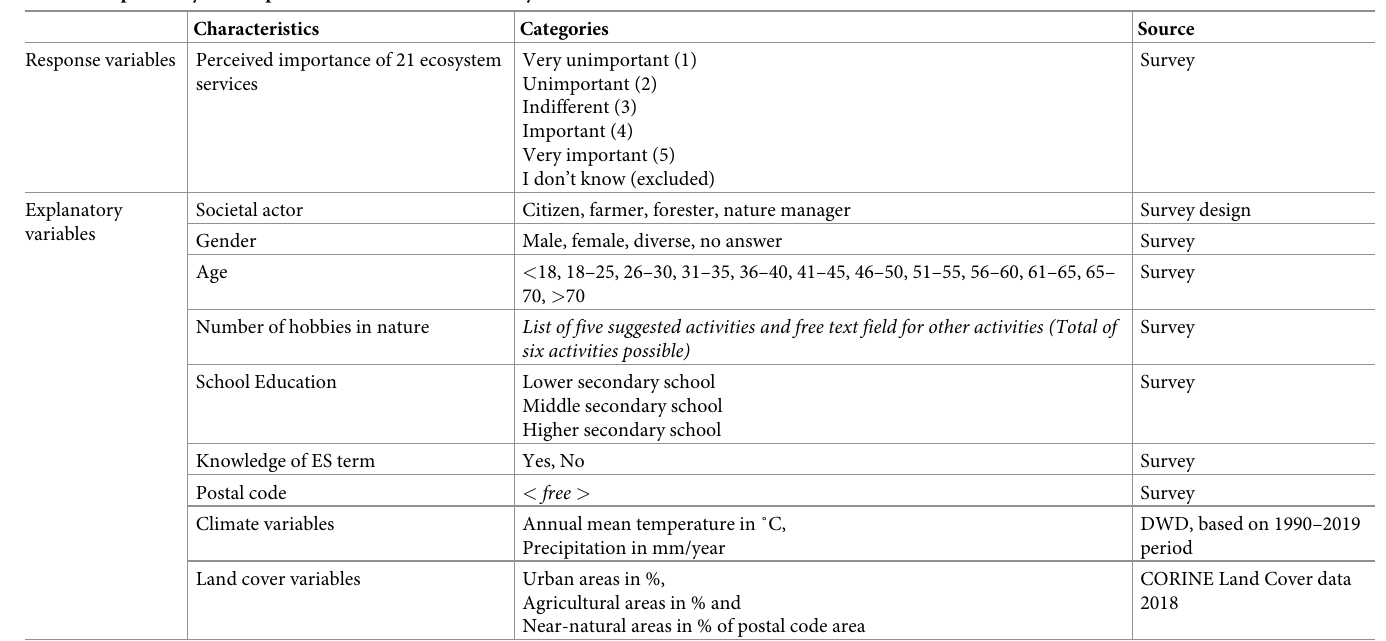
Table 1. Explanatory and response variables used in the